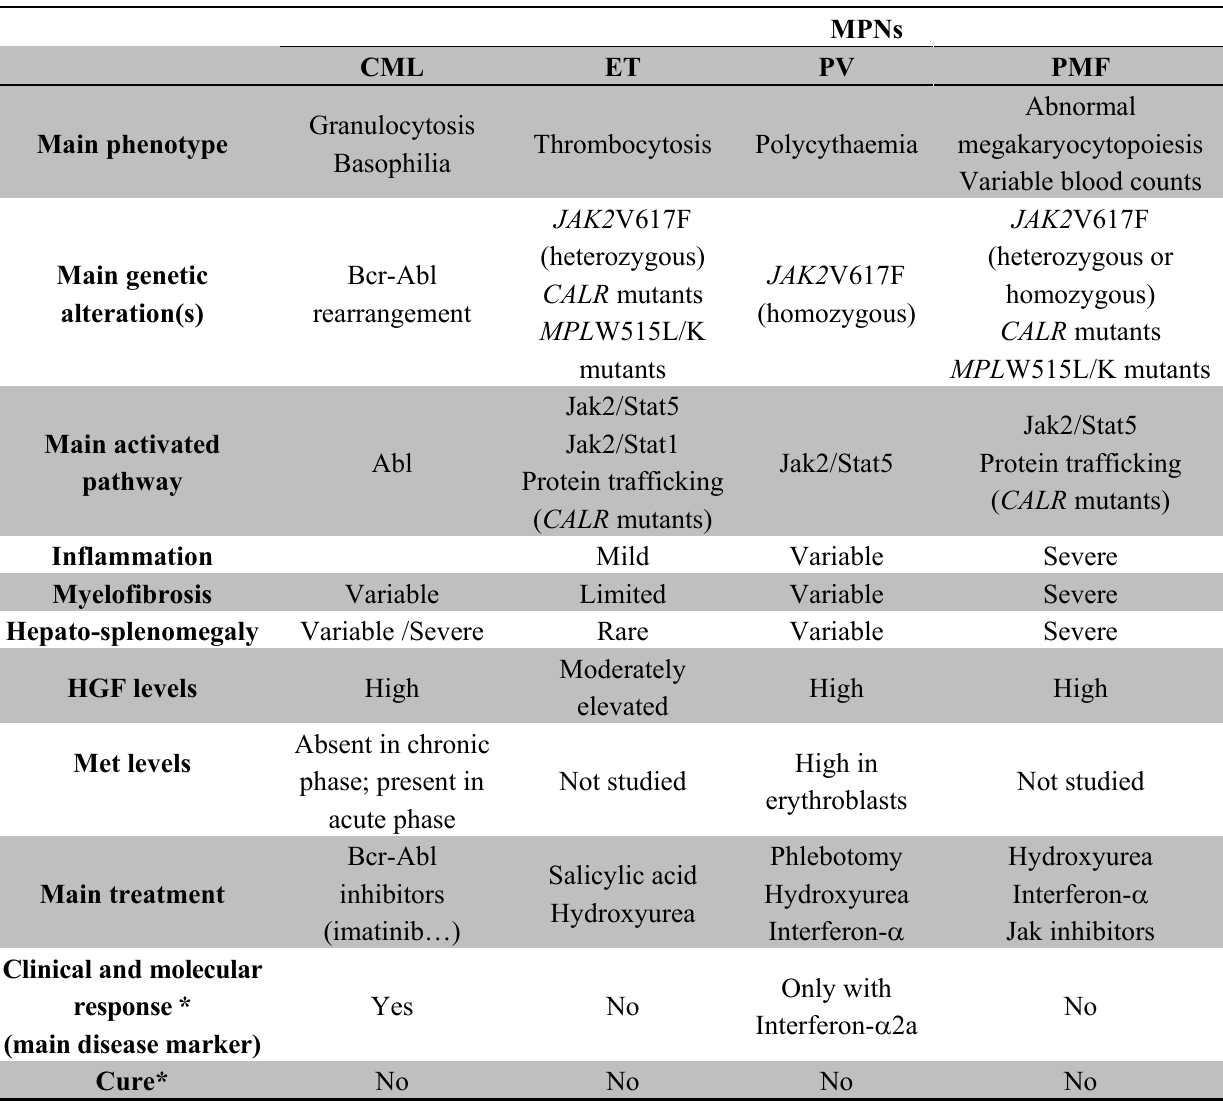
Table 1. Main characteristics of chronic myeloproliferative